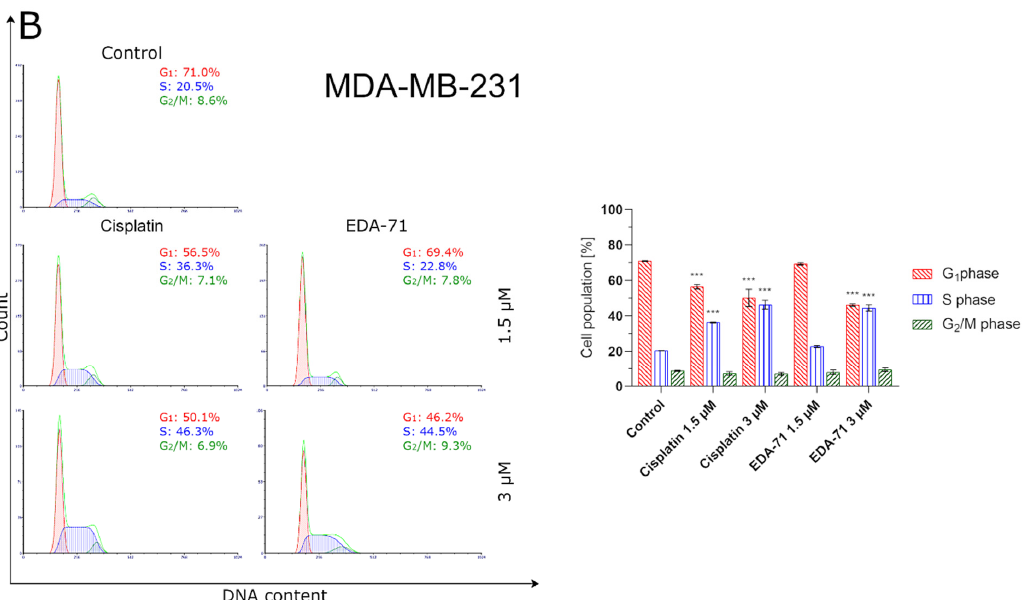
Figure 13. Cytometric analysis of cell cycle distribution in MCF-7 ( A ) and MDA-MB-231 ( B ) breast cancer cells after 24 h incubation with EDA-71 and cisplatin (1.5 and 3 µM). Results are presented as mean values ± SD obtained from three independent experiments ( n = 3) conducted in triplicate. Statistical differences between the experimental (treated cells) and control (untreated cells) groups were determined using one-way ANOVA followed by Dunnett’s test. ** p < 0.01 vs. control group, *** p < 0.001 vs. control group.